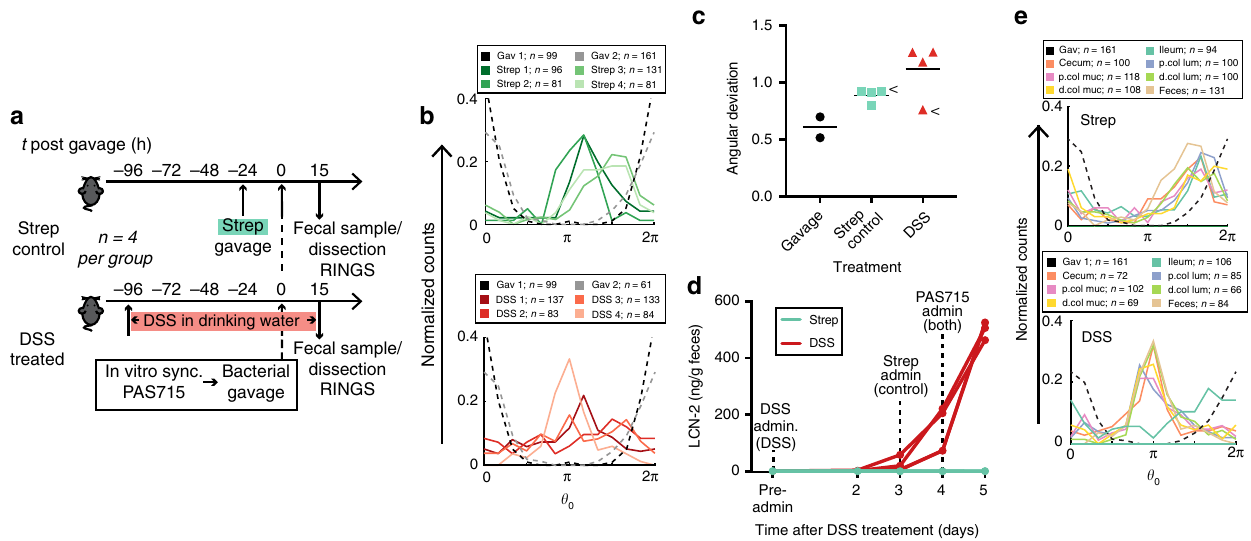
Fig. 6 RINGS identi fi es increased growth variability in the in fl amed gut and between gut niches. a RINGS was used to compare PAS715 growth between the dextran sulfate sodium (DSS) in fl amed, or streptomycin treated, mouse gut. b Histograms of normalized bacterial phase counts in gavage (black and grey) and fecal samples extracted 15 h post gavage in streptomycin (green) and DSS (red) treated mice c Bacteria extracted from feces of DSS-treated mice (red) showed elevated RINGS variability compared to gavage (black) and streptomycin (green) treated mice. Graphs show angular deviation of each datapoint and mean. Arrows identify mice dissected and analyzed in e . d Quanti fi cation of LCN-2 in feces 15 h post gavage demonstrates elevated in fl ammation in DSS-treated mice. e Bacteria plated from the dissected mouse gut of streptomycin control (top; n = 1) and DSS-treated (bottom; n = 1) mice. Graphs show histograms of normalized bacterial phase counts from populations dissected from regions of the gut (various colors) and feces (brown) compared to the original gavage (black). Source data are provided as a Source Data fi slowed over the initial 24-h period (Fig. 4a – d, Supplementary Fig. 5a – e) RINGS analysis was performed beginning the day after IPTG removal on fecal samples taken ~daily, with well under a single period of growth expected between each timepoint (Fig. 5f).